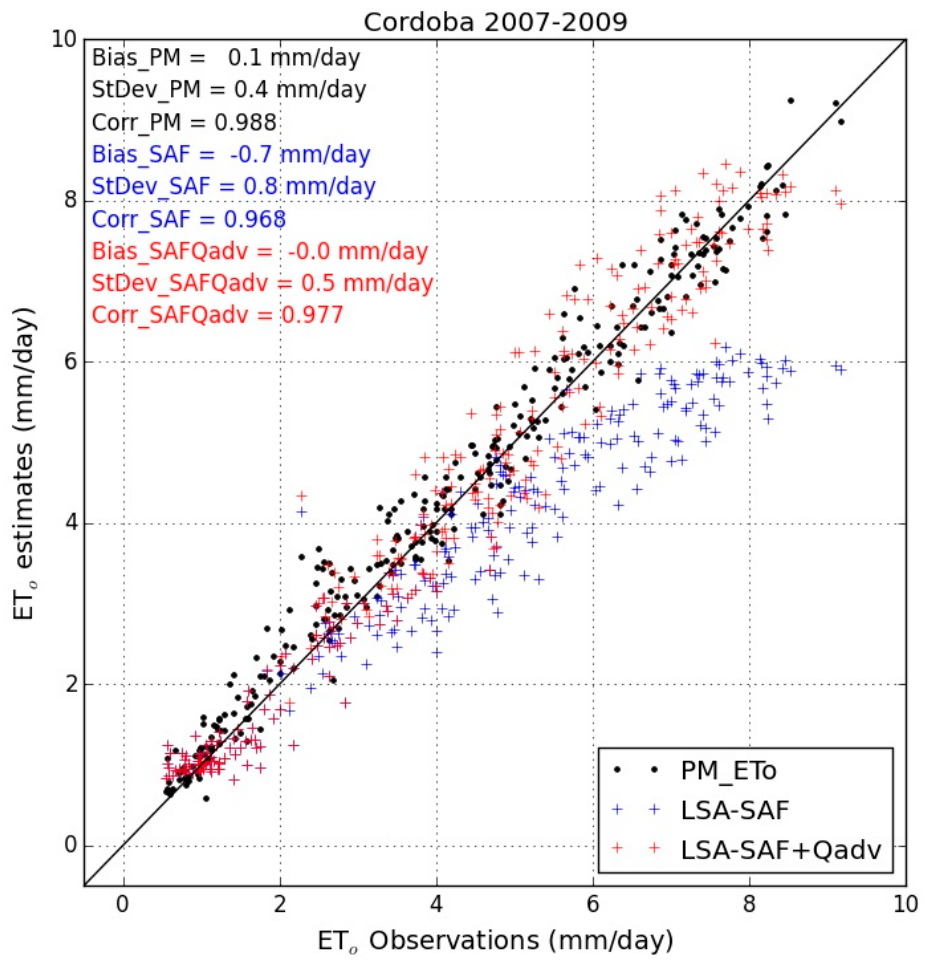
Figure 2. Daily estimates of reference evapotranspiration as obtained by the LSA-SAF without (blue crosses) and with an adjustment term to account for local advection effects (red crosses), versus daily in situ observations obtained for Cordoba Lysimeter site, for the 2007–2009 period. For reference, Penman-Monteith (PM_ETo) estimates obtained using in situ observations at the lysimeter site are also plotted (black dots). The mean difference (bias), standard deviation of differences and correlation between estimations and observed time-series are also shown.